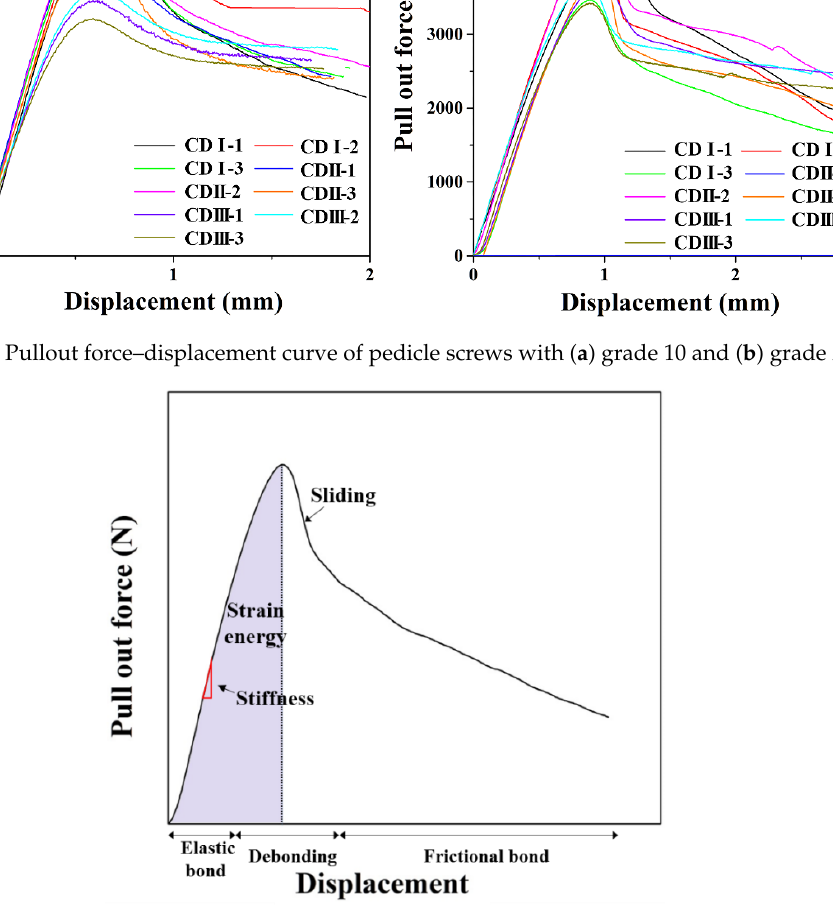
Figure 5. Schematic diagram of pullout behavior.